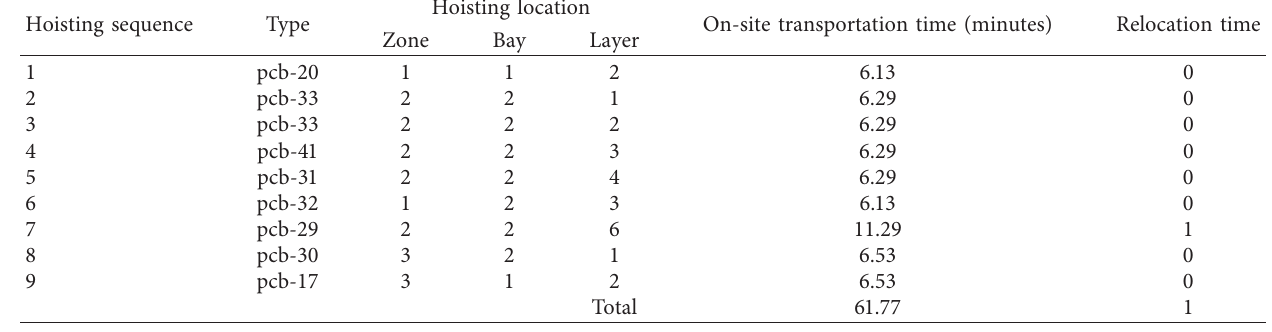
Table 4: Position and on-site transportation time in the third period.